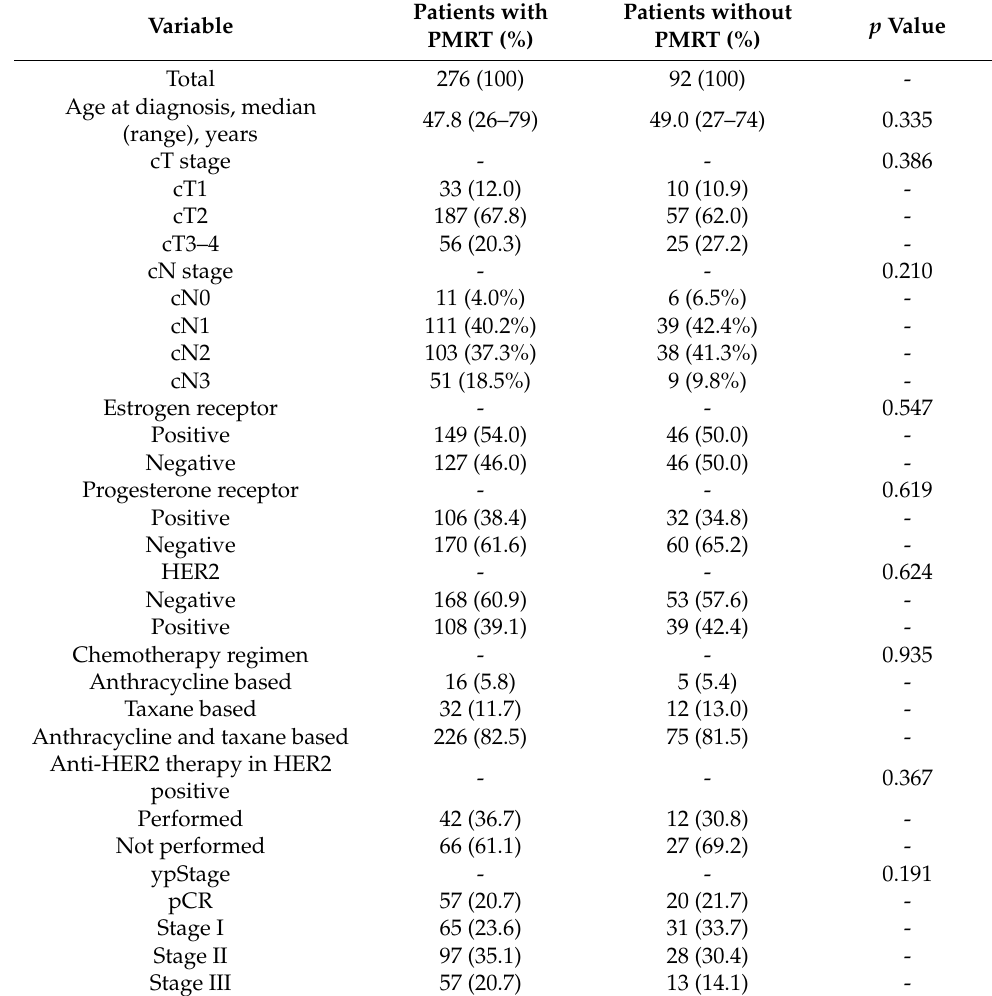
Table 2. Clinicopathologic characteristics of patients after 1:3